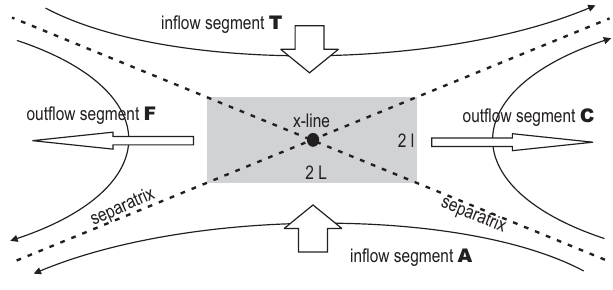
Fig. 1. Simple reconnection at an x-line, or a separator. The four separatrices that meet at the separator divide the space into four topologically distinct segments, which are labeled as F(ree), T(oward), A(way) and C(losed) for comparison with Fig. 2. The shaded area represents the diffusion region D R , and its dimensions are referred to as 2 L × 2 l when the Sweet-Parker model is discussed in Sect.